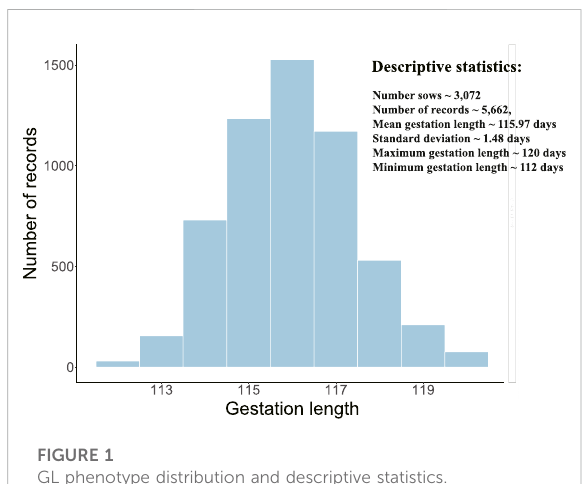
FIGURE 1 GL phenotype distribution and descriptive